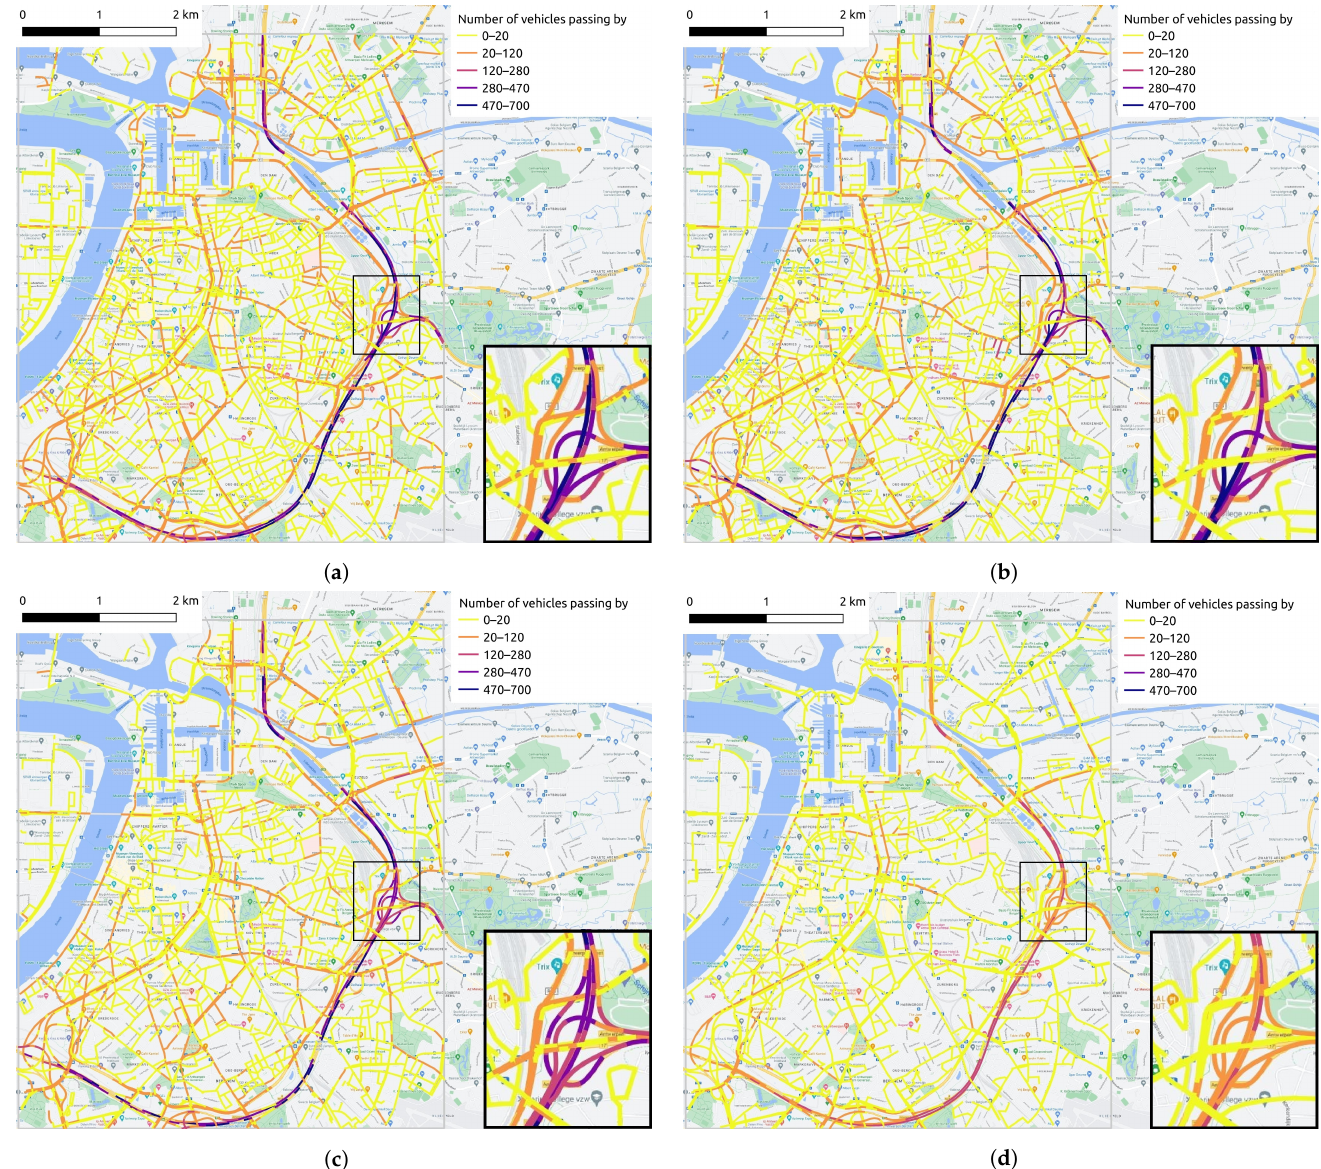
Figure 8. Traffic volume (i.e., the number of vehicles passing per 5 min) on road segments in study area at ( a ) 9:00, ( b ) 13:00, ( c ) 17:00 and ( d ) 21:00 on 10 June 2021. A small region is enlarged for better visualization in the bottom right